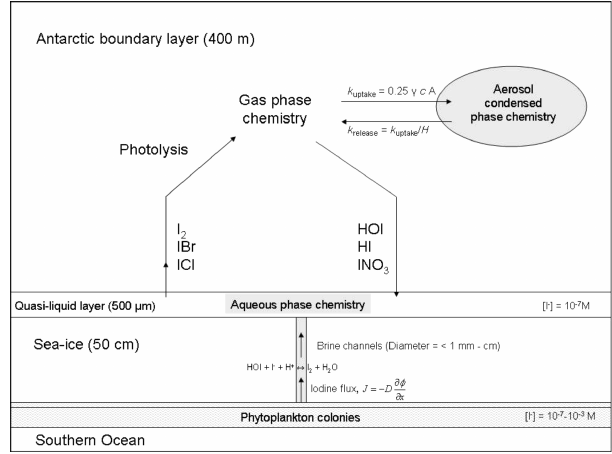
Figure 2. A simplified quantitative schematic of the proposed mechanism and the CON-AIR model structure. Note that the di- mensions are not at real